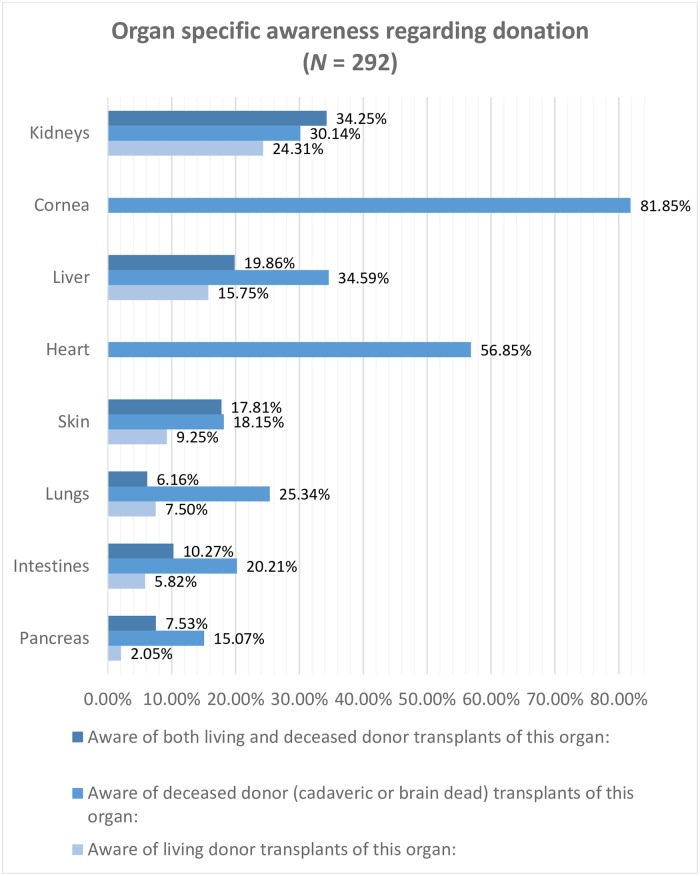
Shows percentage of study population aware of the possibility of donor transplants for different possible organs.